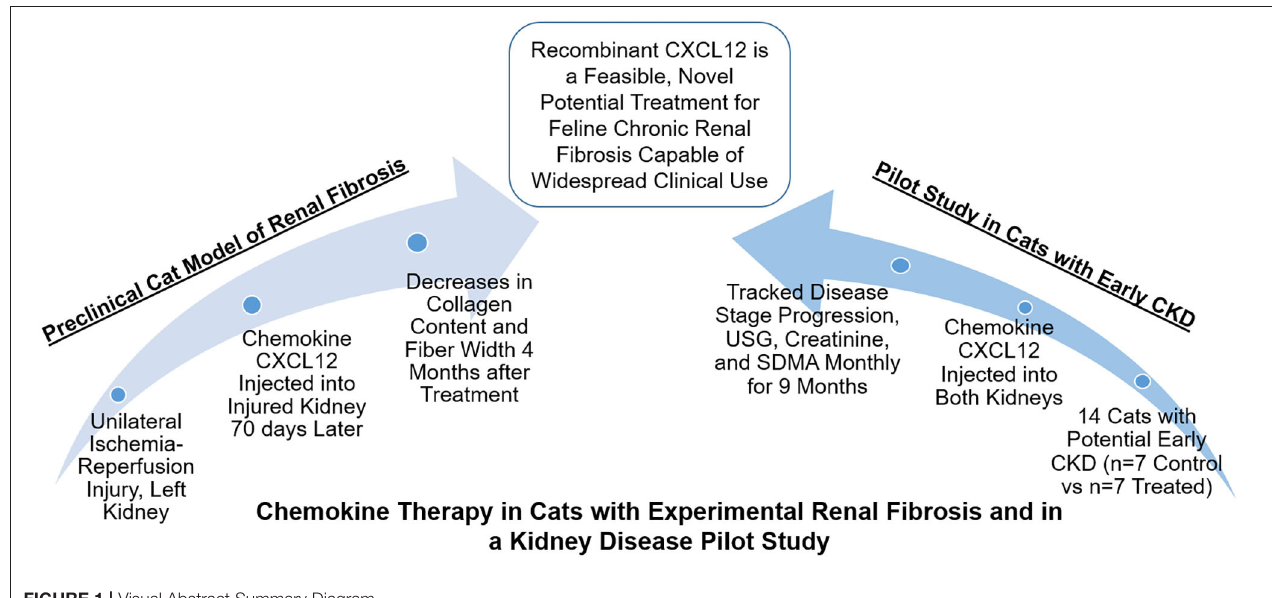
FIGURE 1 | Visual Abstract Summary Diagram.